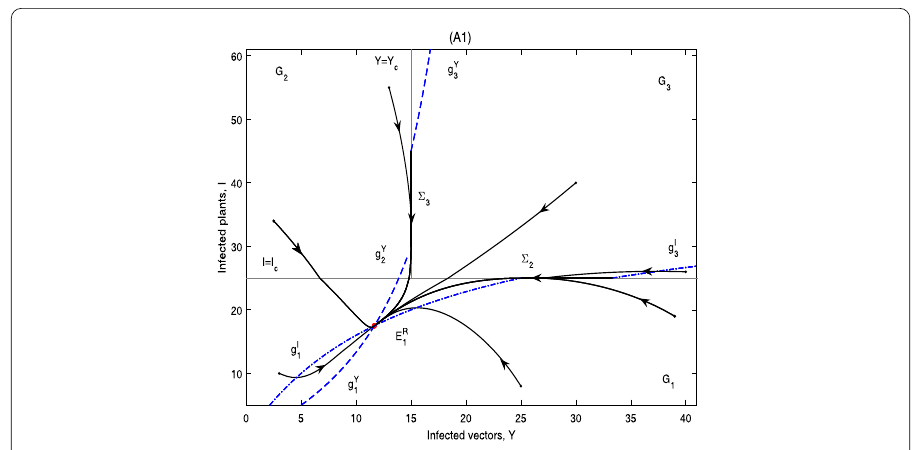
Figure 15 E R 1 is globally asymptotically stable in Case D.13 corresponding to different sliding modes Σ 3 . ( A1 ) Y c = 15, I c = 25. Σ 3 = { ( Y , I ) ∈ Ω 2 : g 1 < I < g 2 } . ( A2 ) Y c = 13, I c = 26. Σ 3 = { ( Y , I ) ∈ Ω 2 : I c < I < g 2 } .